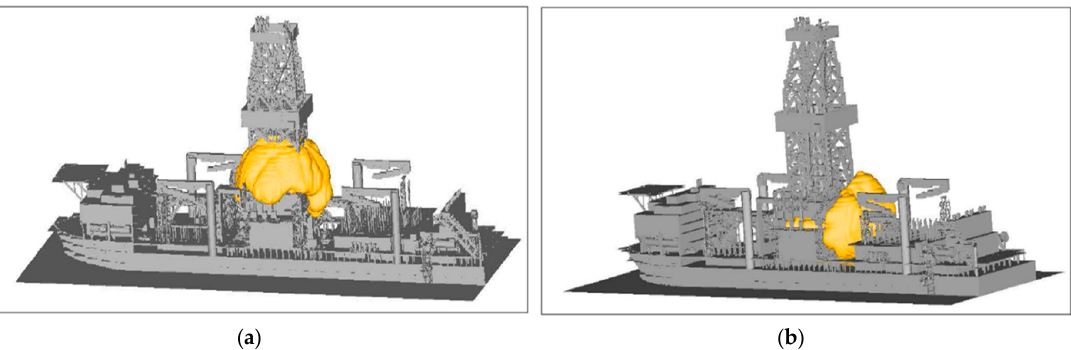
Figure 7. ( a ) Visualization of flame 1.117 s after the gas cloud filling 50% of the derrick volume is